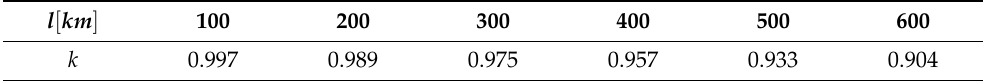
Table 2. Coefficient k change values depending on the line length.